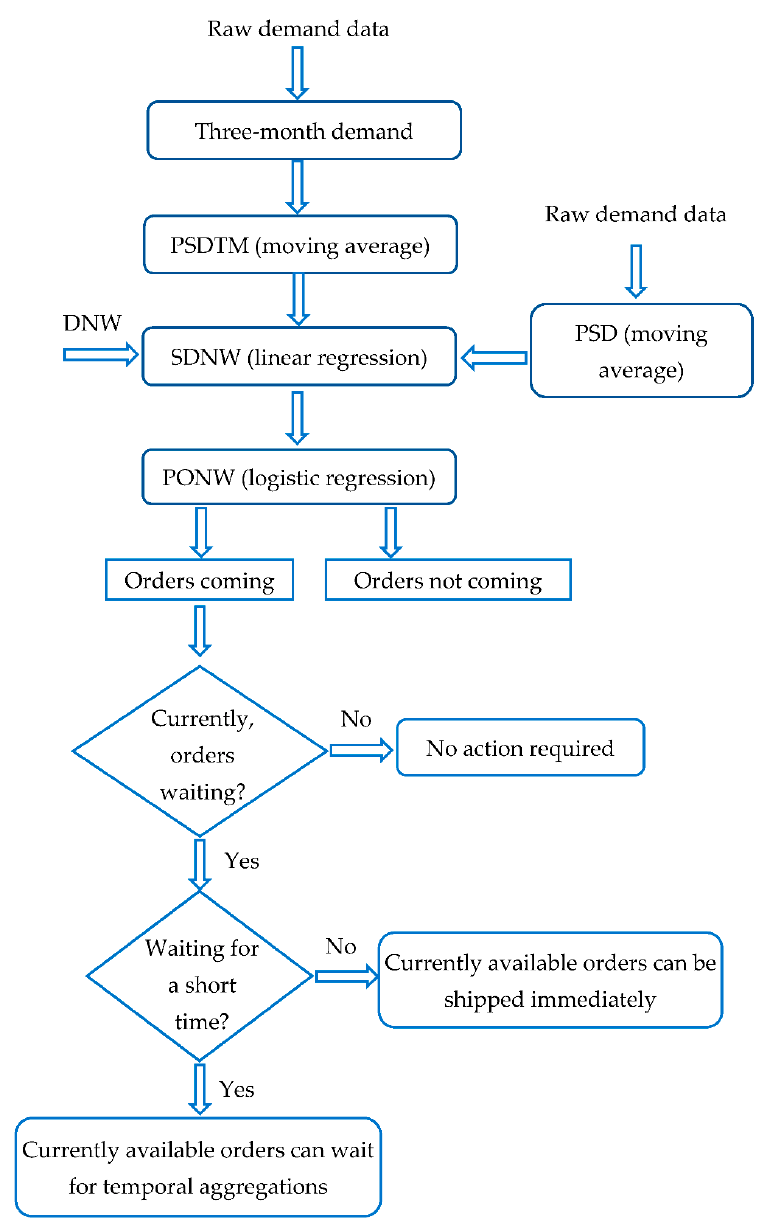
Figure 1. Methodology of the study.